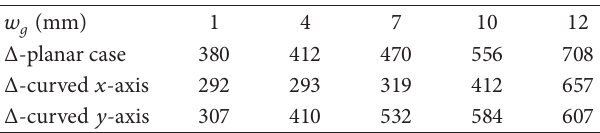
Table 2: The slope width Δ (MHz) as a function of the ground plane circular ring width 𝑤 𝑔 = 𝑅 𝑜 − 𝑅 𝑠 for antenna no. 4. The width of the ground plane circular ring is regulated by changing the radius 𝑅 𝑜 with the other dimensions unchanged. The curvature radii 13cm and 30 cm were assumed for the antennas curved around the 𝑥 -axis and the 𝑦 -axis, respectively.